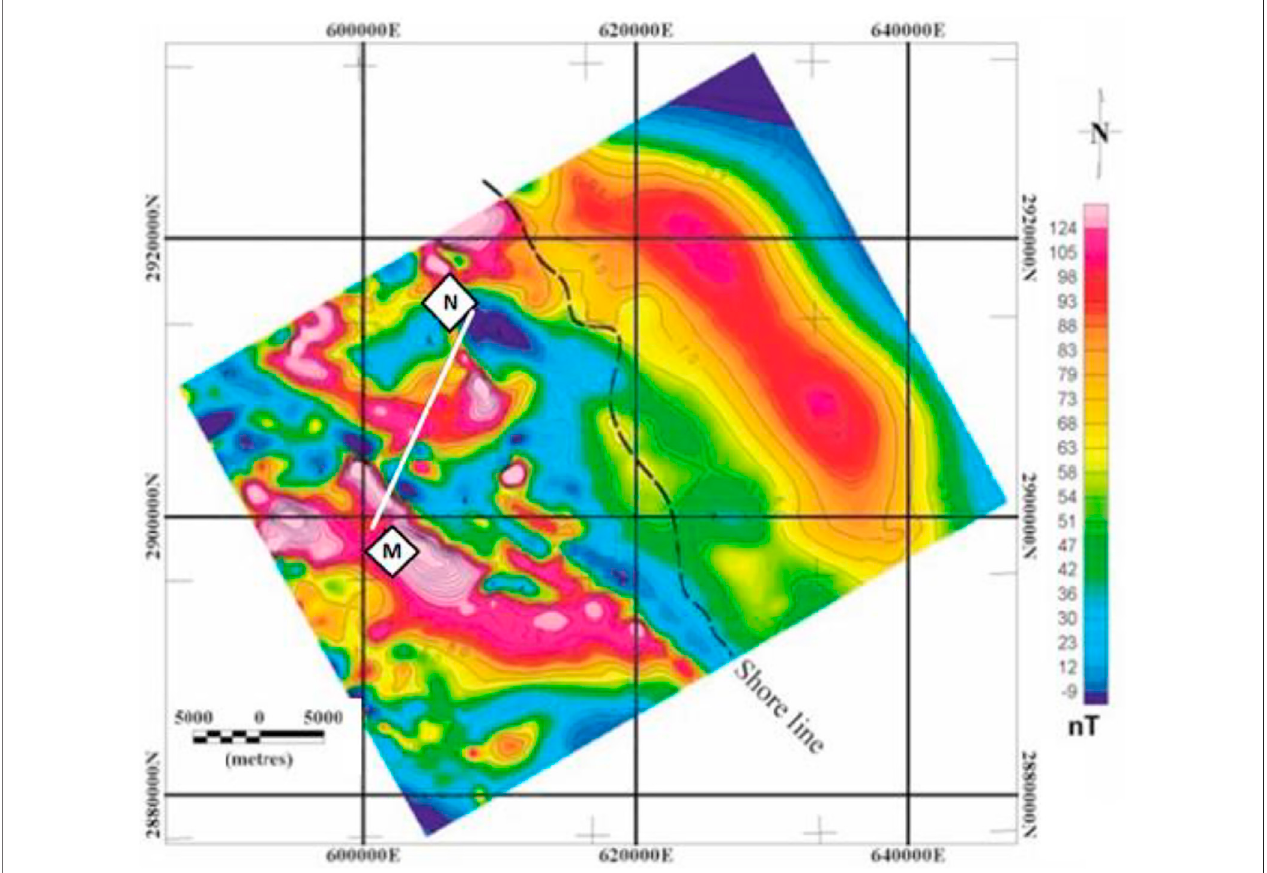
FIGURE 13 | Magnetic intensity map of the Hamrawein fi eld area showing Pro fi le MN (redrawn after Essa and Elhussein, 2018).